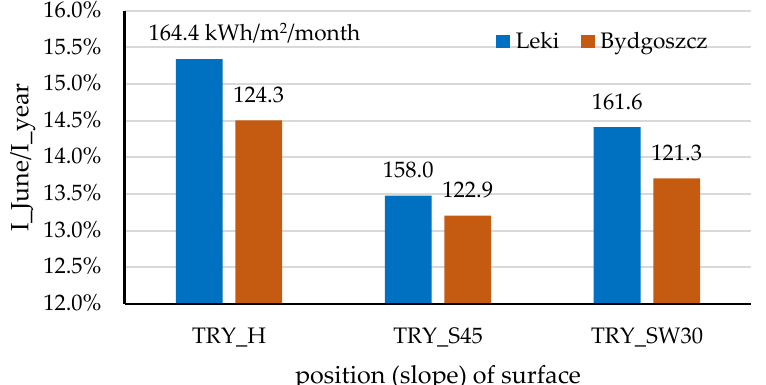
Figure 14. Comparison of the insolation values for both locations for June against the Typical Ref- erence Year data and different location of the surface. (TRY_H–Typical Reference Year–Horizontal Surface, TRY_S45-Typical Reference Year–south directed surface titled 45°, TRY_SW30-Typical Reference Year–south-west directed surface titled 30° [18].